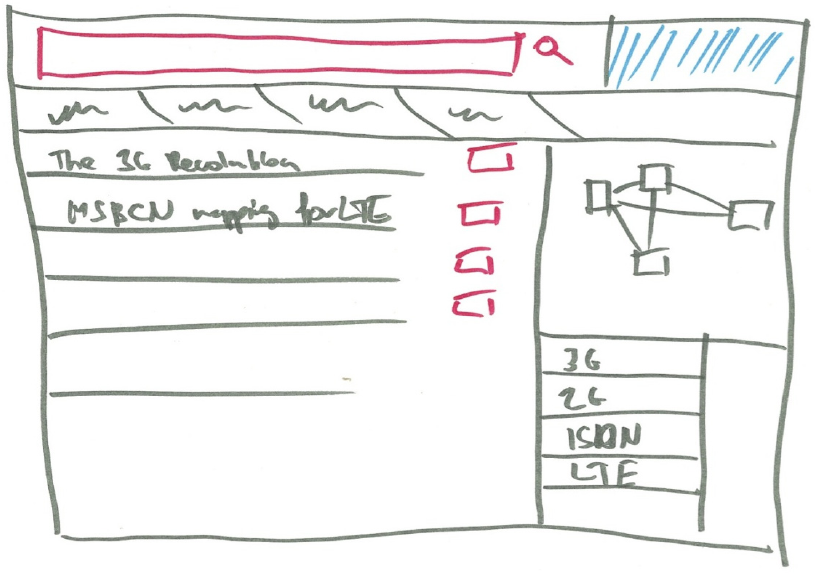
Figure 2. Mockup of the graphical user interface dashboard.